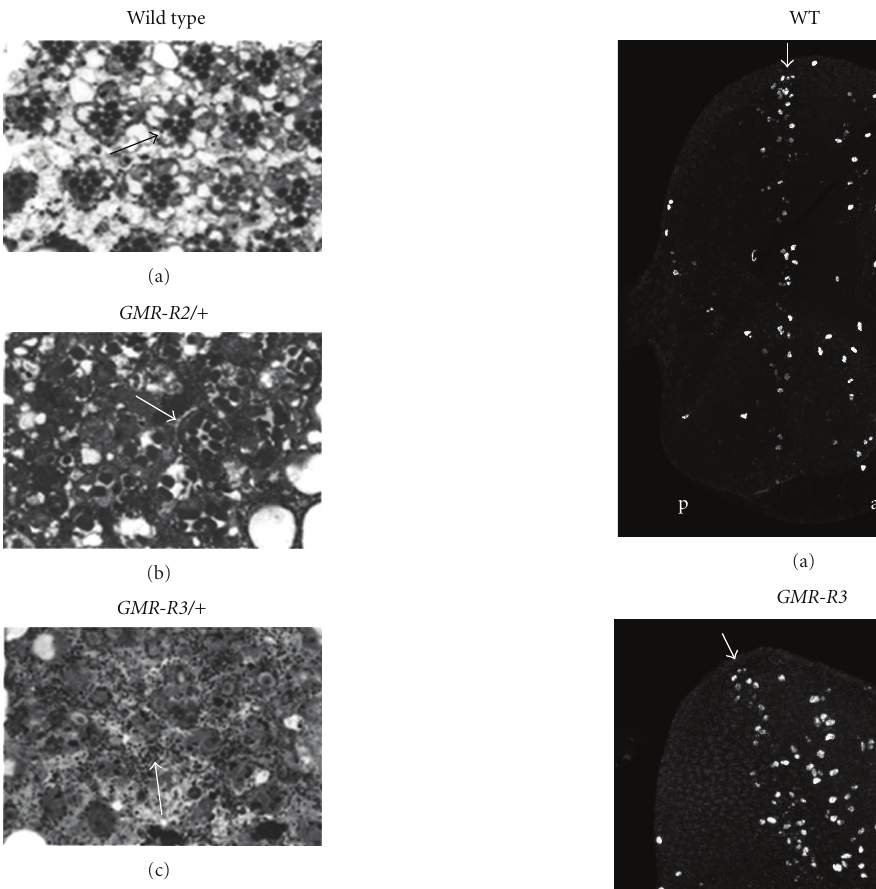
Figure 3: Sections of GMR-R adult eyes. Adult eyes from wild- type (a), GMR-R2/+ (b) and GMR-R3/+ (c) were embedded and sectioned. Arrows in (a) and (b) refer to photoreceptor clusters, arrow in (c) refers to pigment granules. Note that the photoreceptor cluster in (b) contains eight photoreceptors instead of seven.